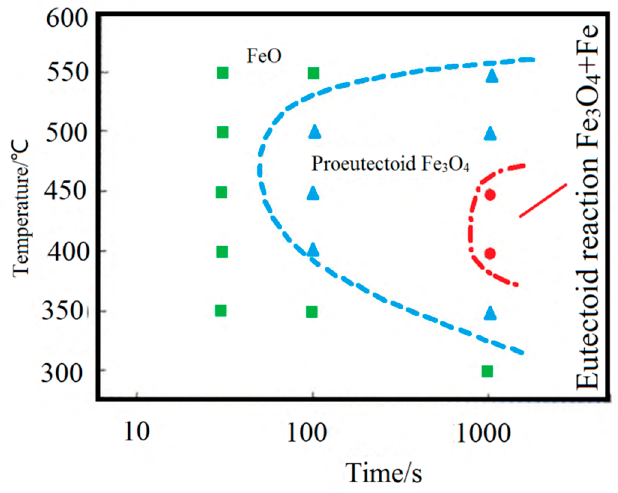
Figure 11. FeO isothermal transformation curve. Reprinted with permission from ref. [18].